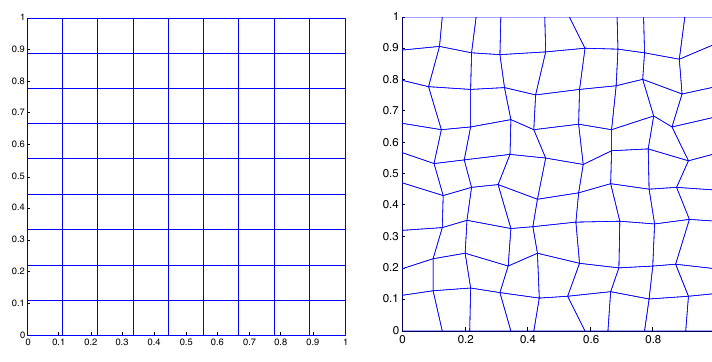
Figure 1. Representative uniform (left) and randomly perturbed (right) quadrilateral grids.